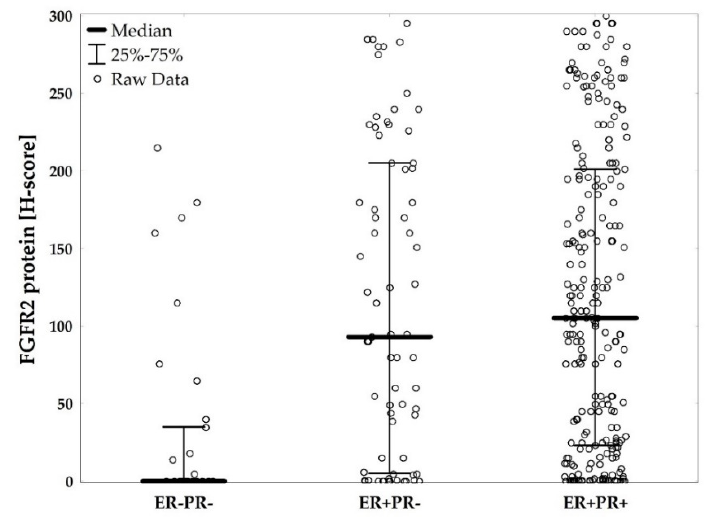
Figure 3. FGFR2 protein levels (H-score) compared between hormonal receptor status subgroups (ER − PR − vs. ER + PR − vs. ER + PR + ), p < 0.001. p -value from Kruskal–Wallis ANOVA test.